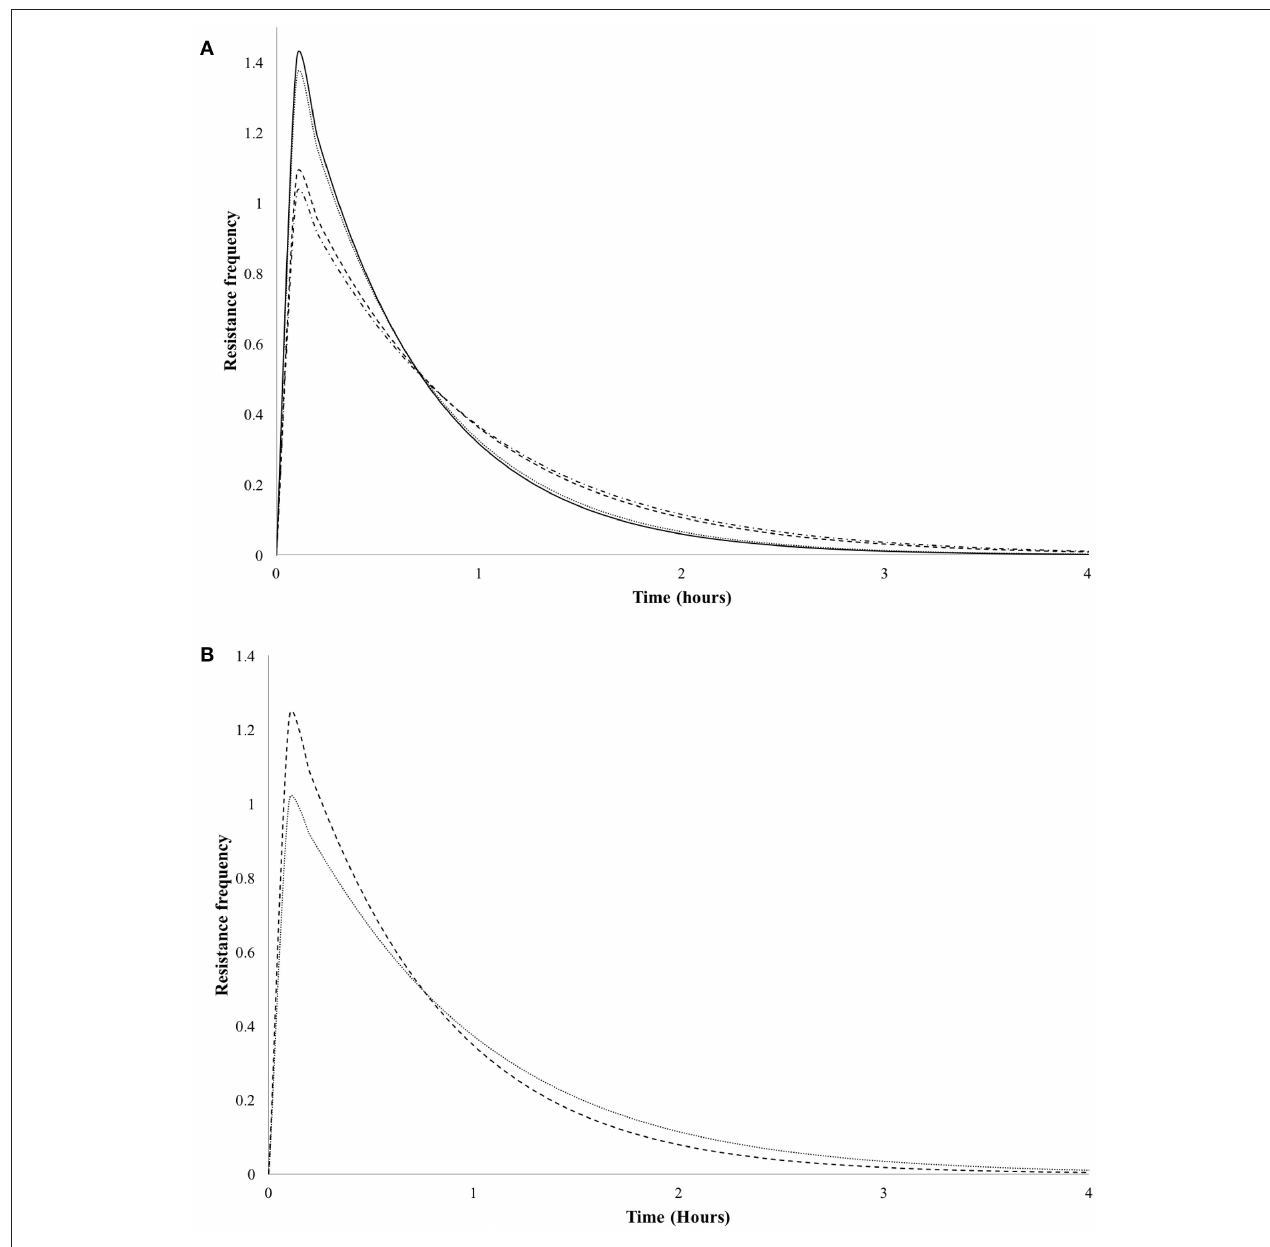
FIGURE 2 | Resistance frequency curves of Vibrio cholerae Non-01 at selected concentrations and molecular weight [low molecular weight 600 (- • - • -) and 1,000 (----); high molecular weight 600 (—), and 1,000 ( •••• ) mg/L] on, at different temperatures 5 ◦ C (A) and 35 ◦ C (B)